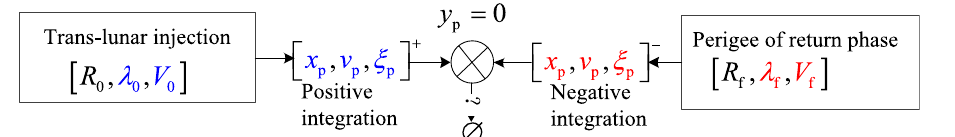
Figure 4. Illustration of the existence validation strategy.